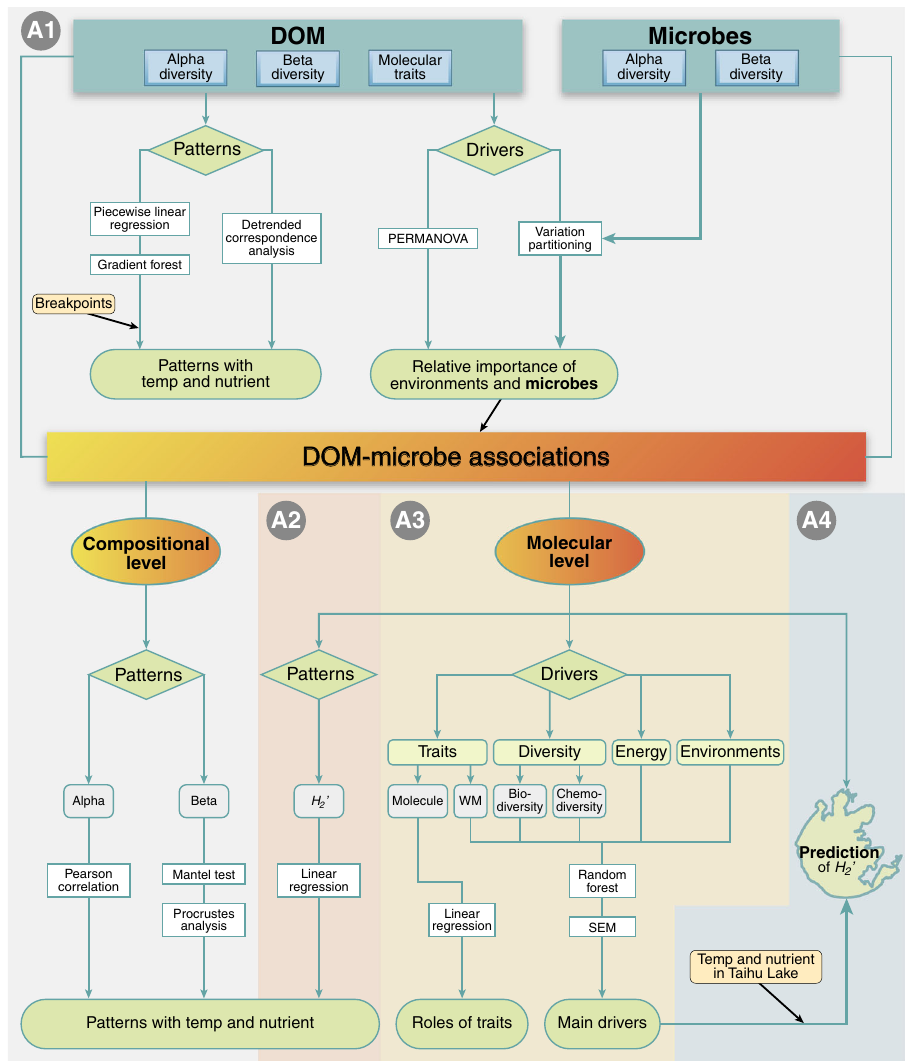
Fig. 2 Outline of statistical analyses to address the study aims. A1 – A3 refer to the three main questions stated in the ‘ Introduction ’ , and A4 refers to the prediction of H 2 ′ in Taihu Lake. The response or explanatory variables in grey or light blue boxes were examined by the statistical methods in white boxes for the main purposes indicated in light green boxes or an irregular shape box. The irregular shape shows the lakeshore of Taihu Lake. PERMANOVA: permutational multivariate analysis of variance. SEM: structural equation model. Alpha: alpha-diversity of DOM and microbes. Beta: beta-diversity of either DOM or microbes. WM: weighted means of formula-based molecular traits. Temp: temperature. Details for each statistical analysis such as main purposes were described in the ‘ Methods ’